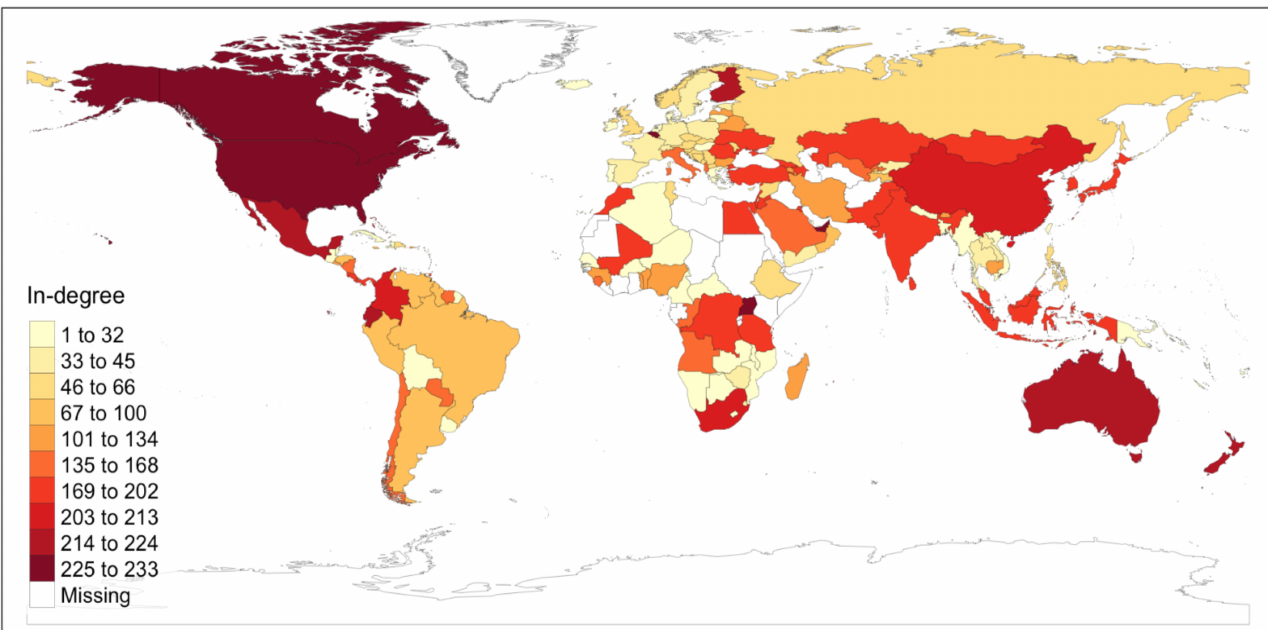
Figure 2. In-degrees. Source: authors.